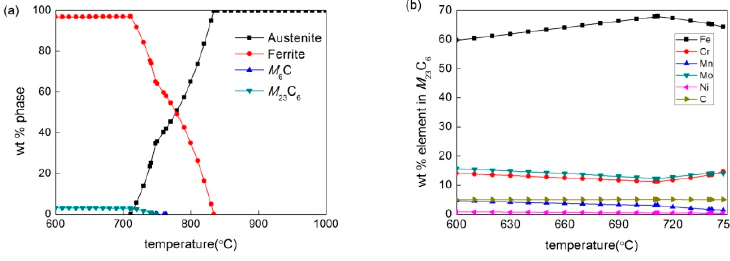
Figure 1. ( a ) Equilibrium phase diagram of G18CrMo2–6 steel; ( b ) composition of M 23 C 6 carbide.